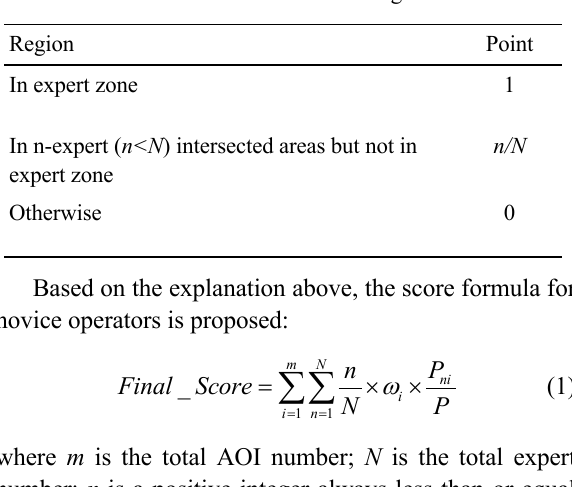
Table 1. Points in different